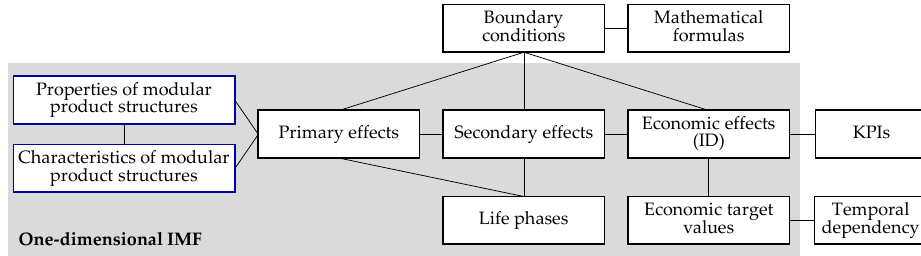
Figure 3. Extended data model of the IMF for the implementation in SysML.